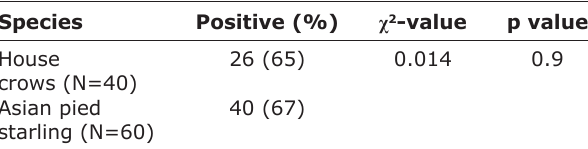
Table-1: Prevalence of Salmonella spp. within two species of resident wild